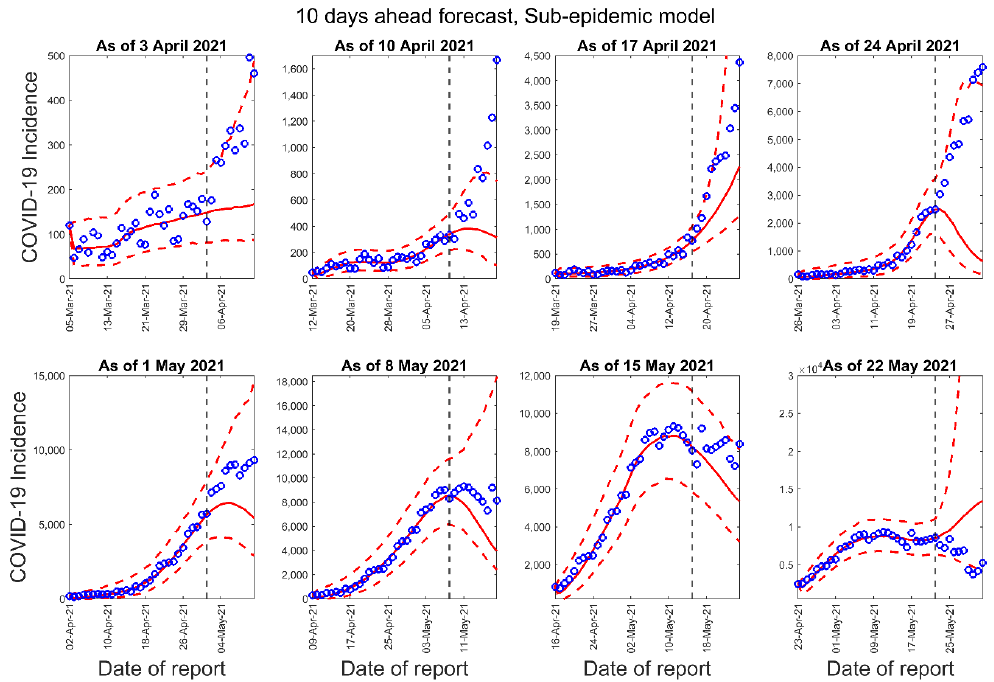
Figure 5. Ten-days ahead forecasts of the COVID-19 epidemic curves in Nepal by calibrating the sub-epidemic model for 8 different periods. Blue circles correspond to the data points; the solid red line indicates the best model fit, and the red dashed lines represent the 95% prediction interval. The vertical black dashed line represents the time of the start of the forecast period.